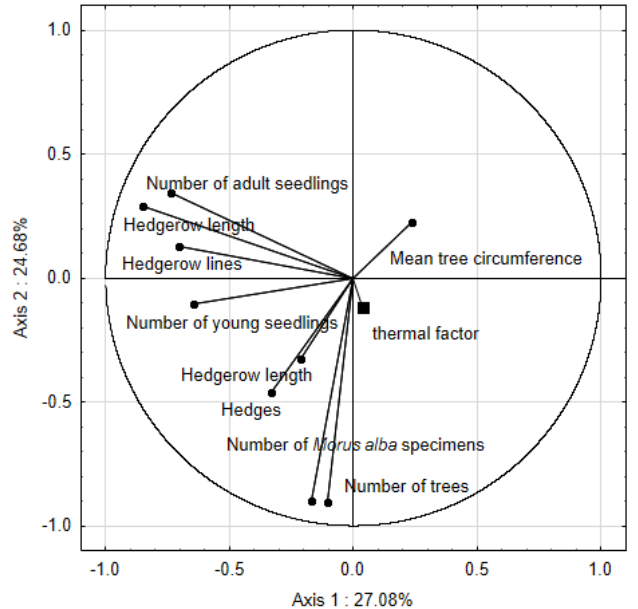
Figure 6. PCA conducted for parameters characterizing the natural and artificial renewal of Morus alba . The thermal factor was introduced into the analysis as an additional variable.